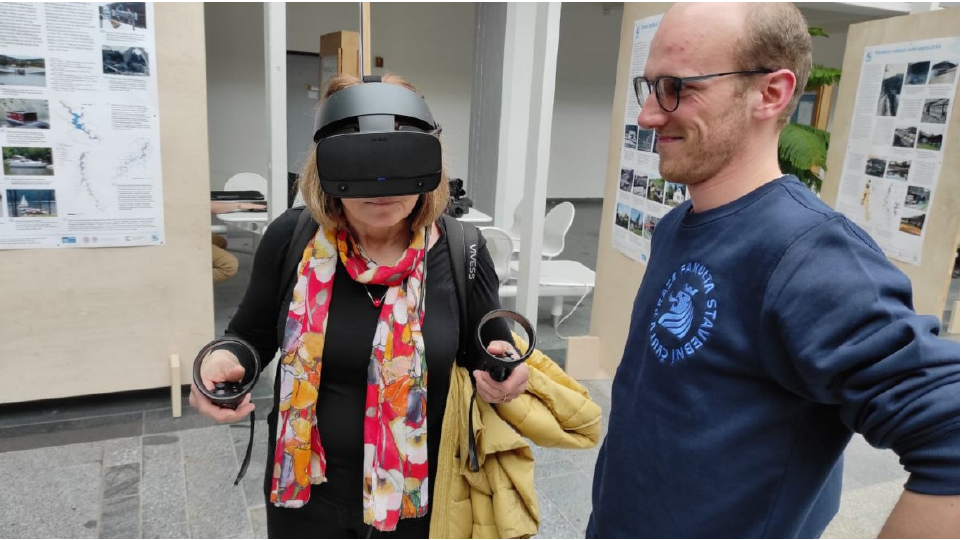
Figure 15. Co-author Vojt ě ch Cehák assisting a visitor at the exhibition Vltava—Transformations of the Historical Landscape .